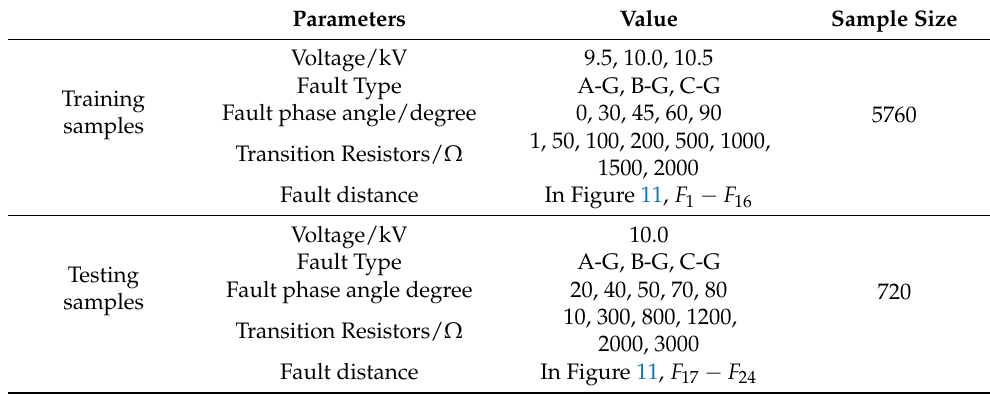
Table 3. Simulation parameter traversal